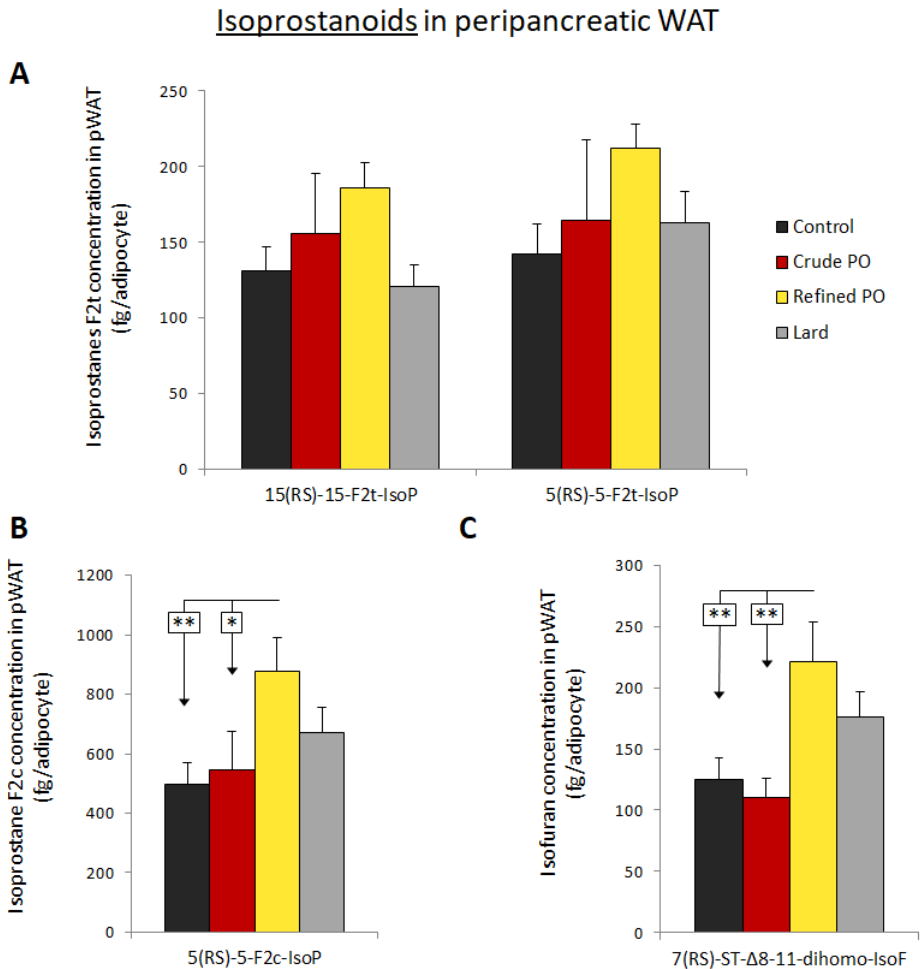
Figure 4. Impact of high intake of palm oils and lard on isoprostanoid concentration in peripancreatic adipose tissue (pWAT). ( A ) Quantification of isoprostanoids with a trans configuration: 15 (RS) -15-F2t-IsoP and 5 (RS) -5-F2t-IsoP (fg/adipocyte). ( B ) Quantification of 5 (RS) -5-F2c-IsoP, an isoprostanoid with a cis configuration (fg/adipocyte). ( C ) Quantification of the isofuran 7 (RS) -ST- ∆ 8 -11-dihomo-IsoF (fg/adipocyte). Isoprostanoids were assayed from 200 mg of adipose tissue per rat. Data are shown as means ± SEM, n = 6–7 animals per group. * p < 0.05 or ** p < 0.01 vs. control diet.